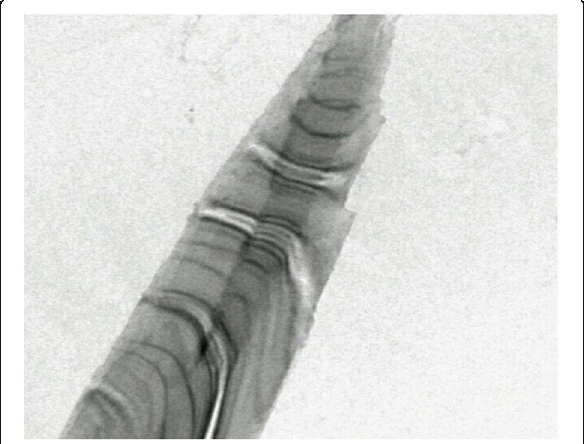
Fig. 8 Transmission electron photomicrographs of RES-NC